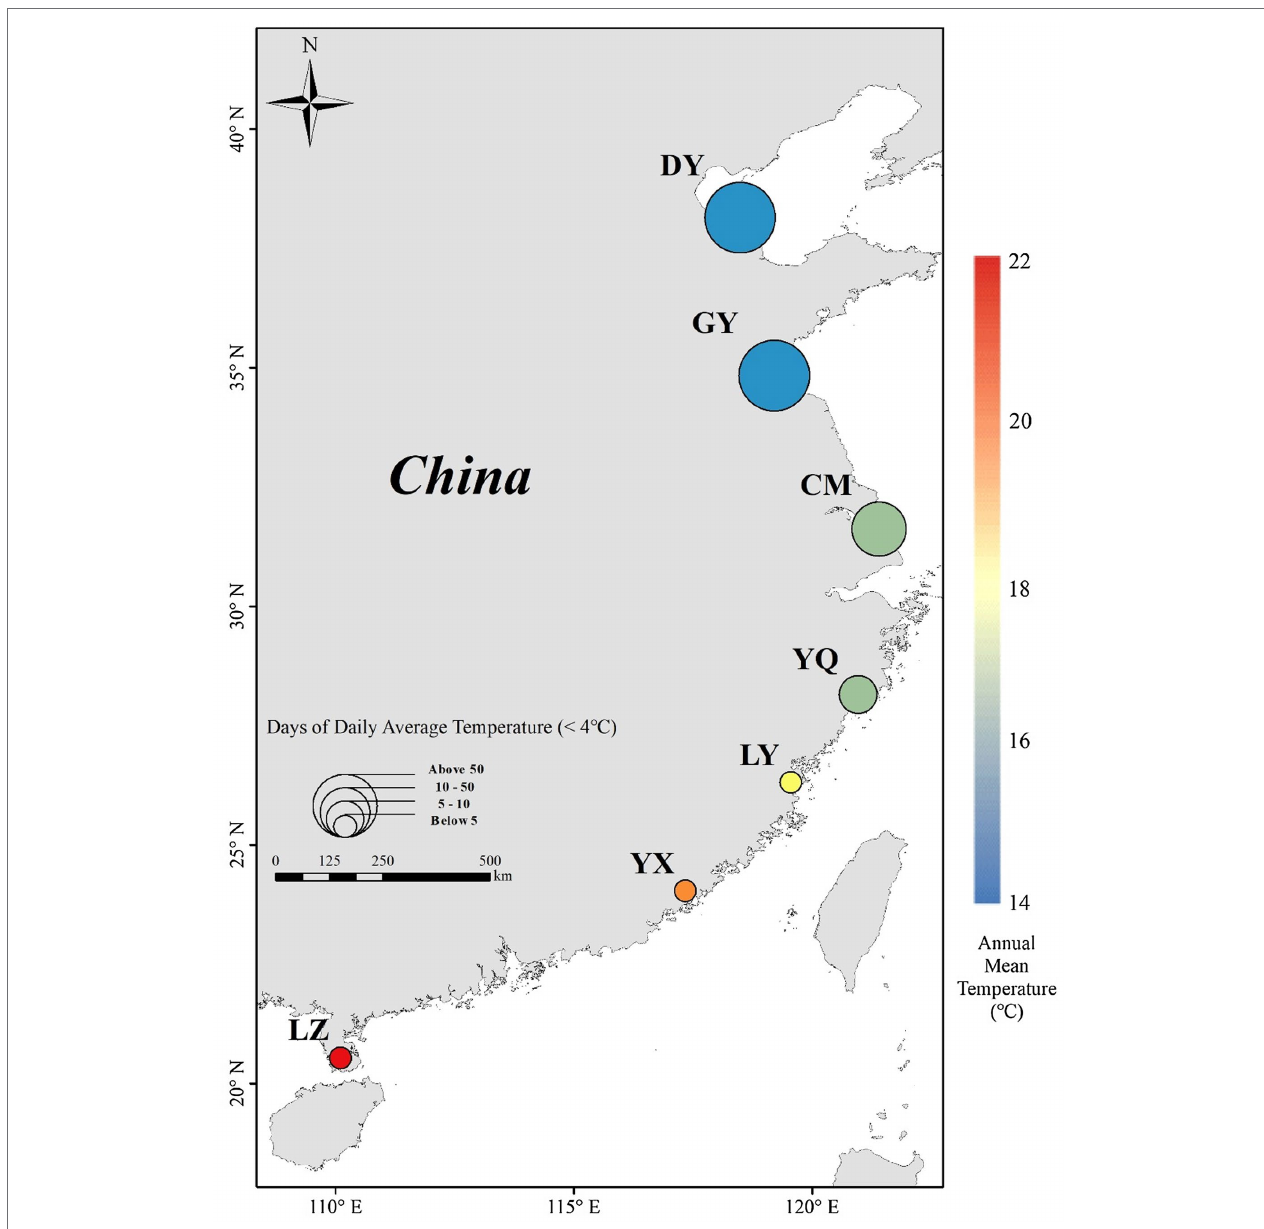
FIGURE 1 | Spartina alterniflora seed collection locations in China (circle), and annual mean temperature (indicated by color) and days of average temperature < 4 ° C (indicated by size of circle) variation across latitude. See Table 1 for site